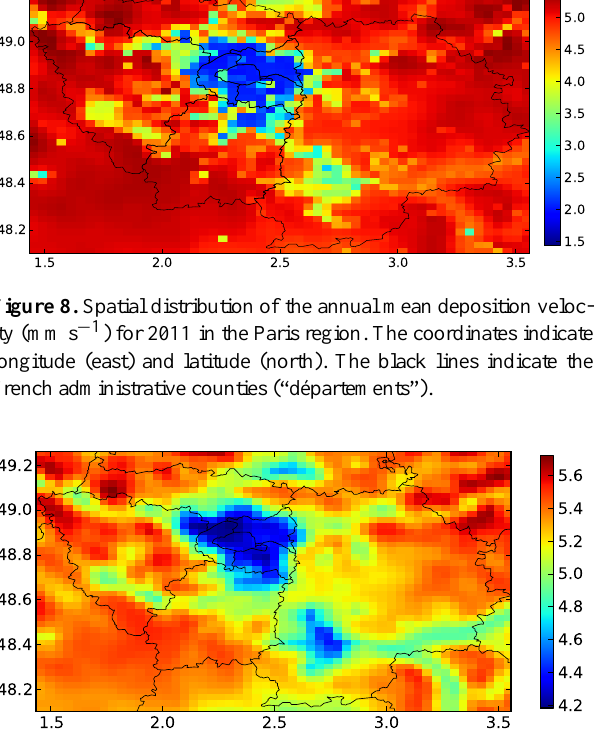
Figure 9. Spatial distribution of the annual mean wind speed at the first model level (m s − 1 ) for 2011 in the Paris region. The black lines indicate the French administrative counties